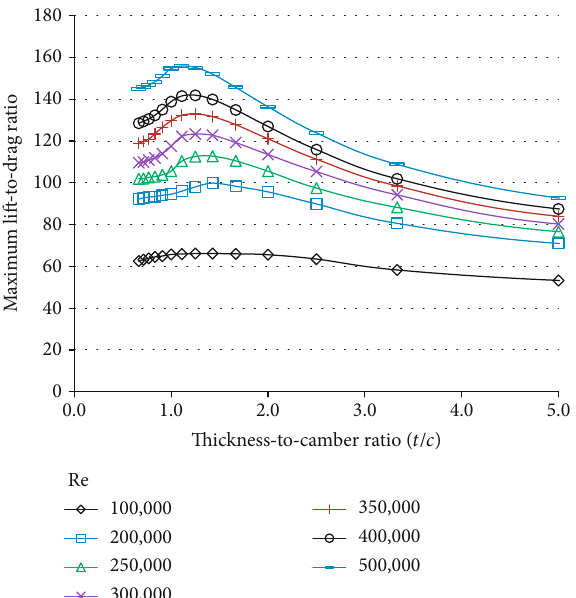
Figure 2: Maximum lift-to-drag ratio at di ff erent thickness-to- camber ratios.